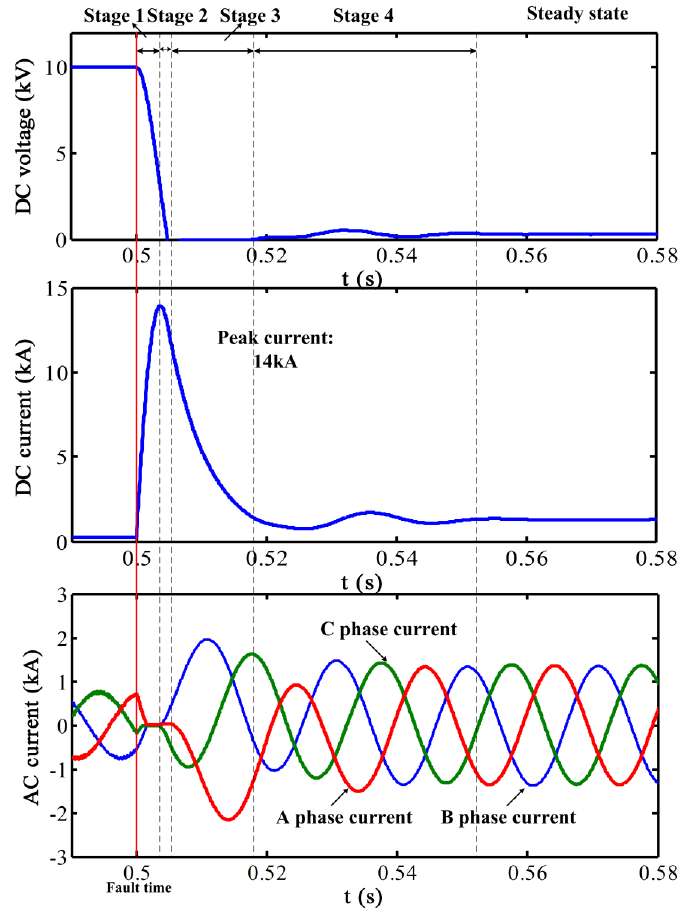
Figure 4. The fault characteristic of the voltage source converter (VSC) without the SFCL during a DC short-circuit